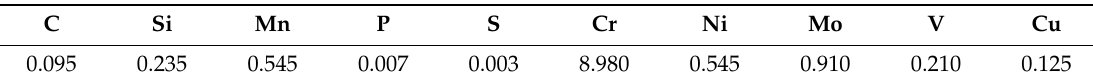
Table 3. Chemical composition of the filler metal